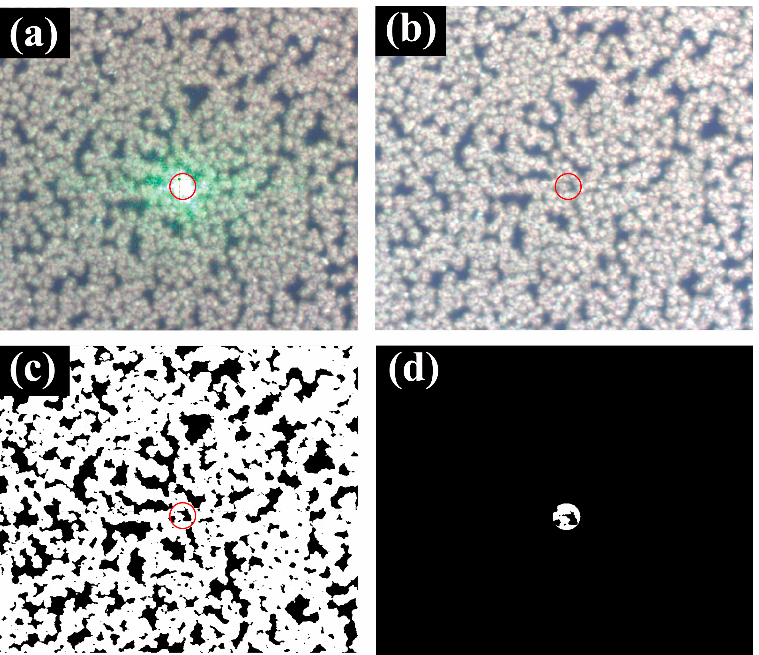
Figure 3. Pictures for duty cycle calculation: ( a ) Laser is turned on and ( b ) off; ( c ) Binarized image; ( d ) Testing area.